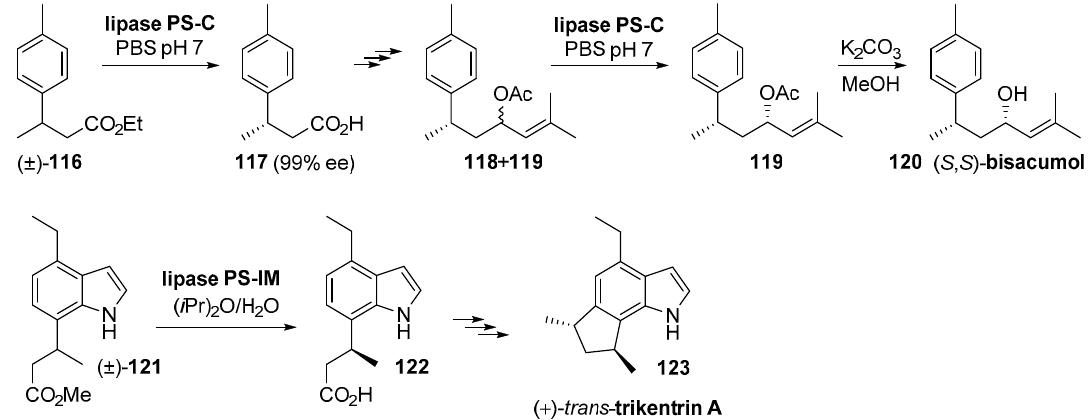
Figure 17. Lipase-mediated resolution of the racemic esters 116 and 121 . Transformation of the obtained chiral building blocks into sesquiterpenes ( S , S )-bisacumol ( 120 ) and (+)- trans -trikentrin A ( 123 ).